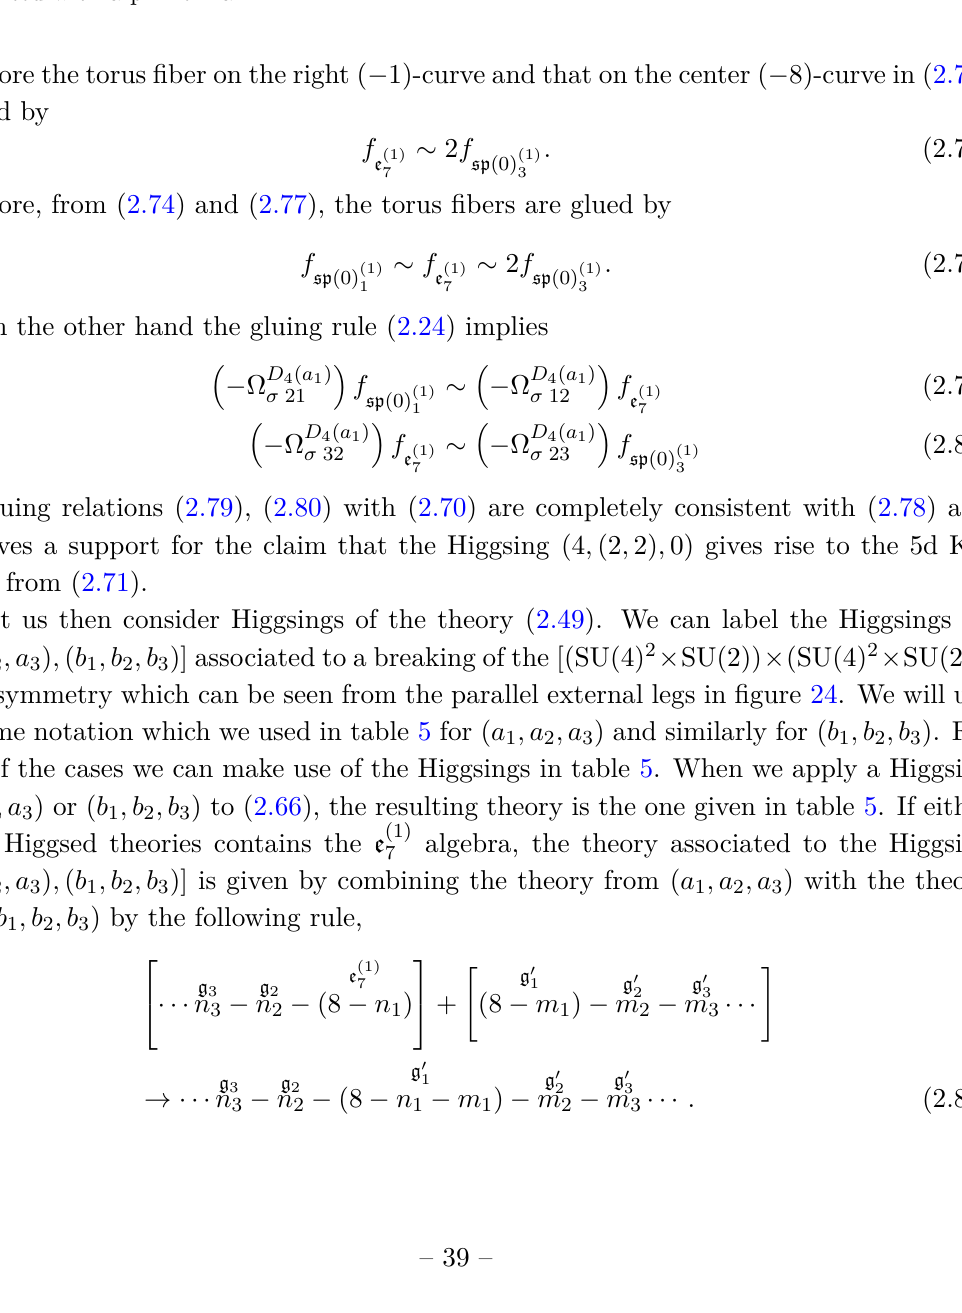
Figure 23. The web diagram of dP 9 which corresponds to the E-string on the right in (2.71). The notation for the curve classes is the same as the one in figure 22. The curve classes here are represented with a prime